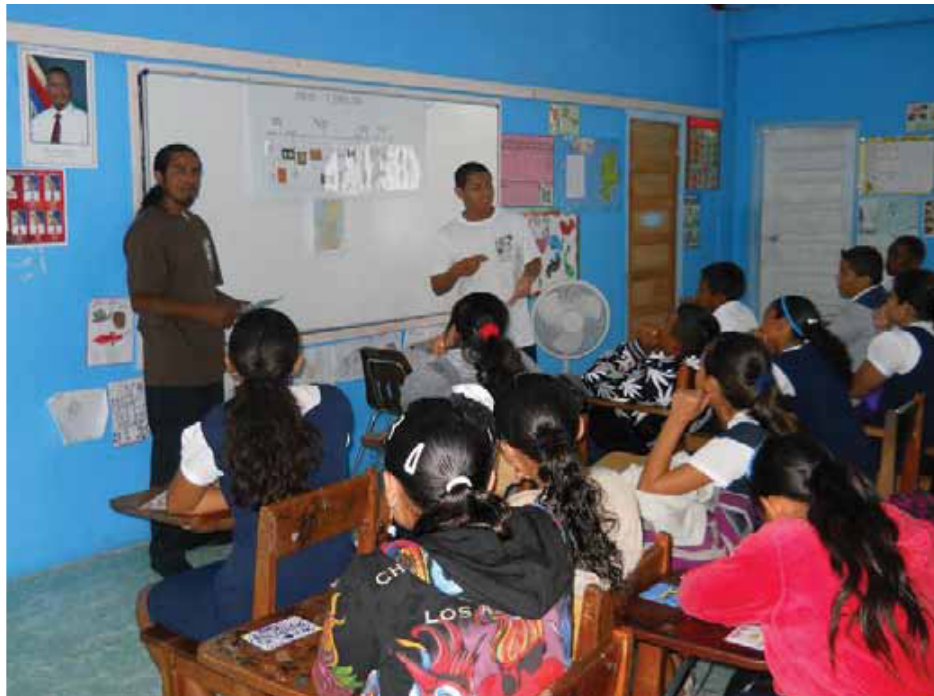
Fig. 3: Victor Cucul and Ismael Teul talking to students at the San Pedro Roman Catholic School, Belize.